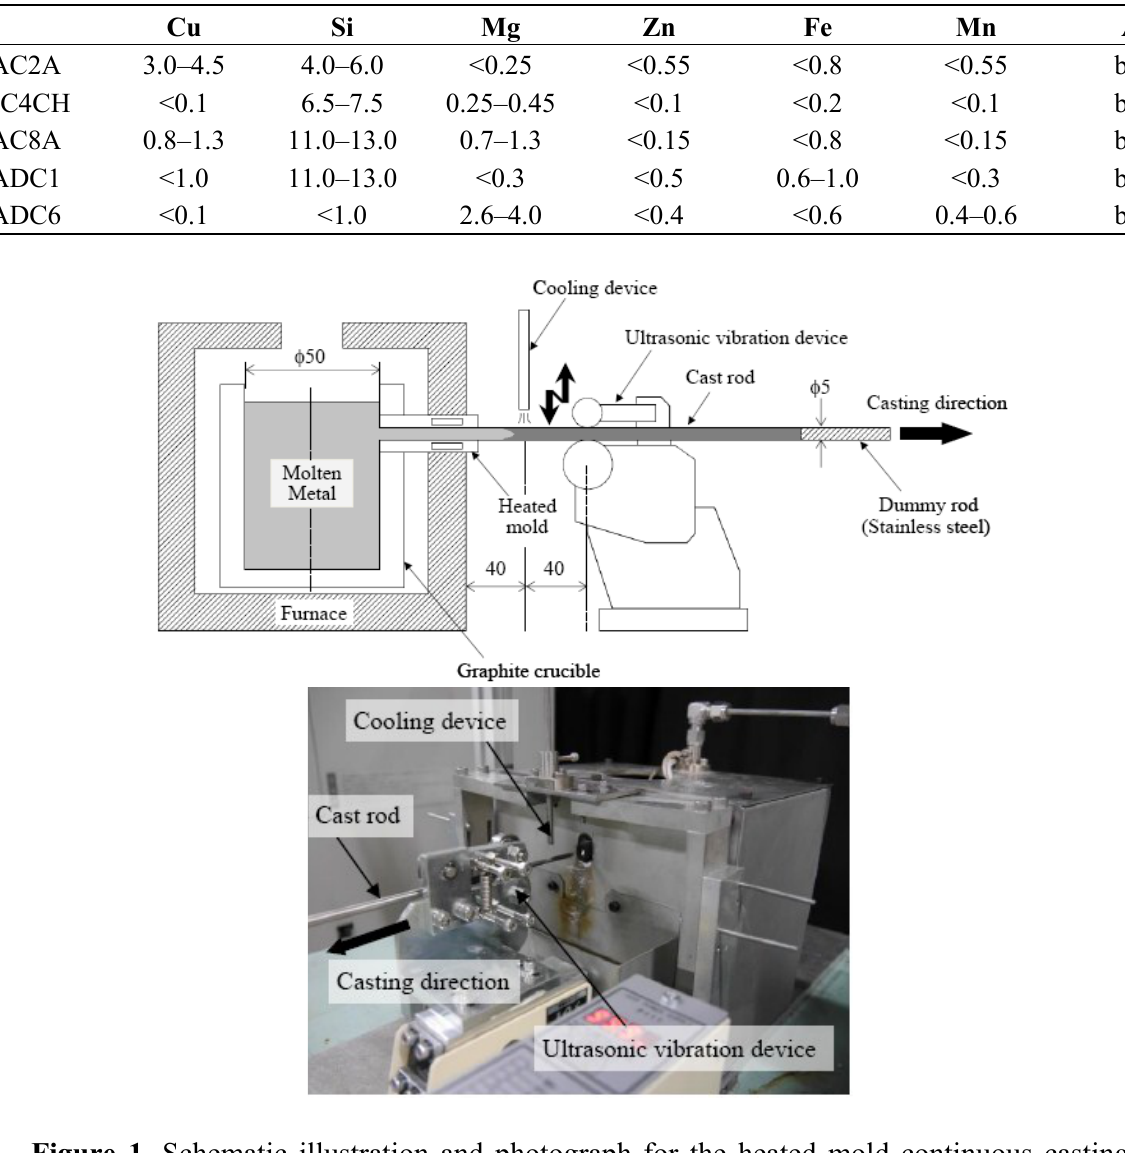
Figure 1. Schematic illustration and photograph for the heated mold continuous casting (HMC) device with ultrasonic vibration